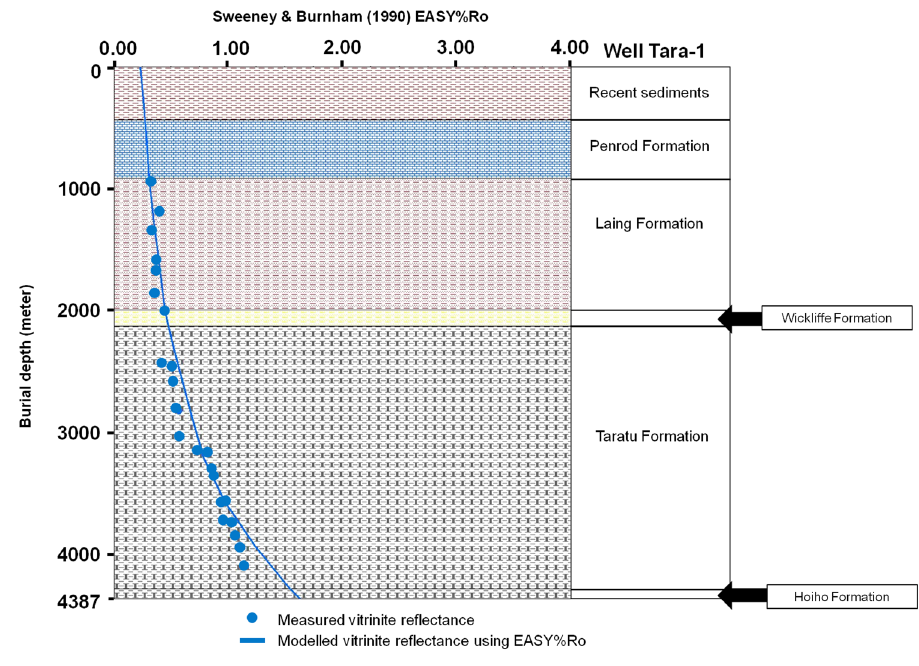
Fig. 15 Calibration of measured and modeled vitrinite reflec- tance values for Tara-1 well